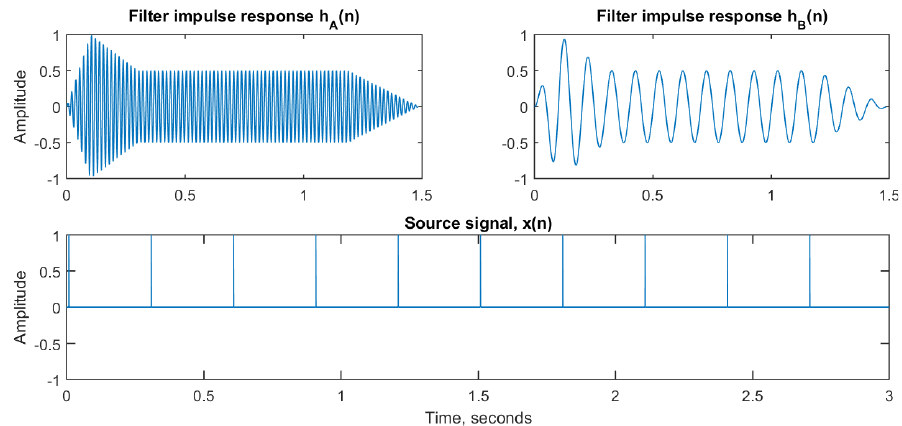
Figure 2. Demonstration of dynamic filter replacement: Top : The two filter impulse responses h A ( n ) and h B ( n ) . Bottom : The input signal x ( n ) .